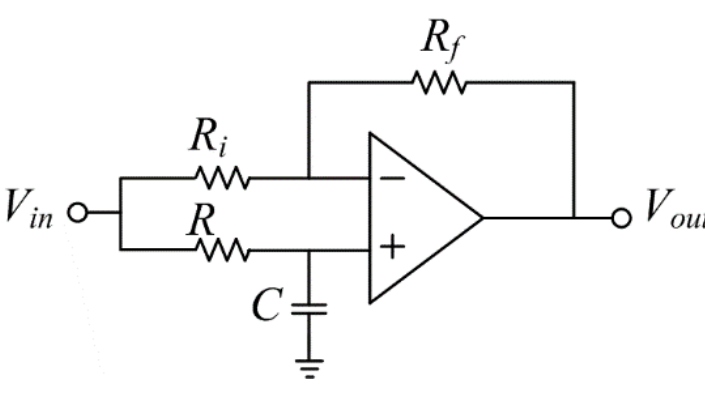
Figure 2. Analog lagging all-pass filter topology.